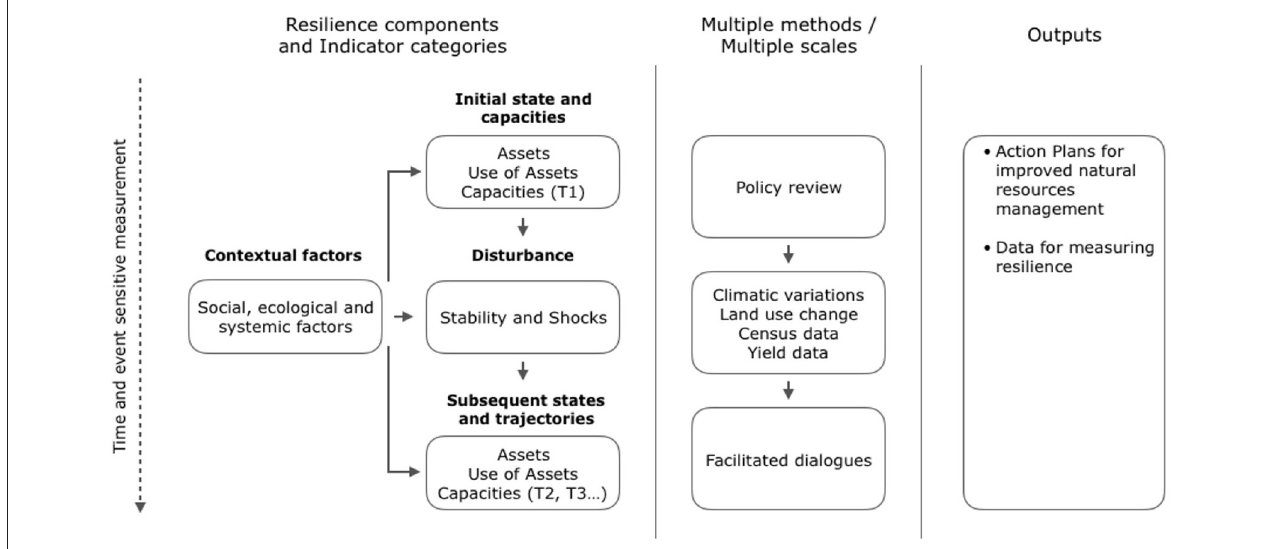
FIGURE 1 | Schematic figure outlining data collection related resilience framework components [after Douxchamps et al. (2017)] in the research study, using a mixed method approach to assess resilience which included landscape assessment using remotes sensing, climate data, desk study of census data and policy review, and the analysis of the community-developed watershed action